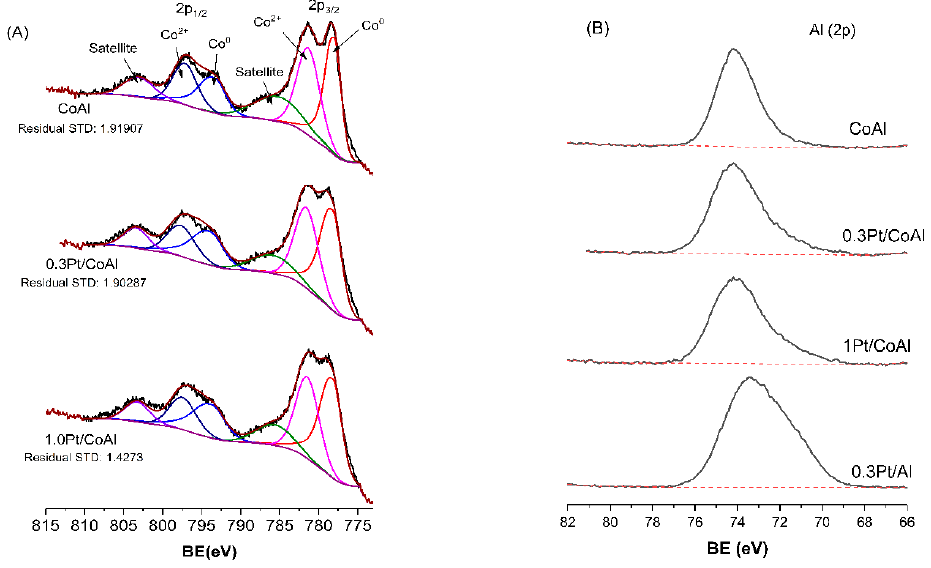
Figure 4. XPS spectra corresponding to ( A ) Co 2p and ( B ) Al 2p for reduced